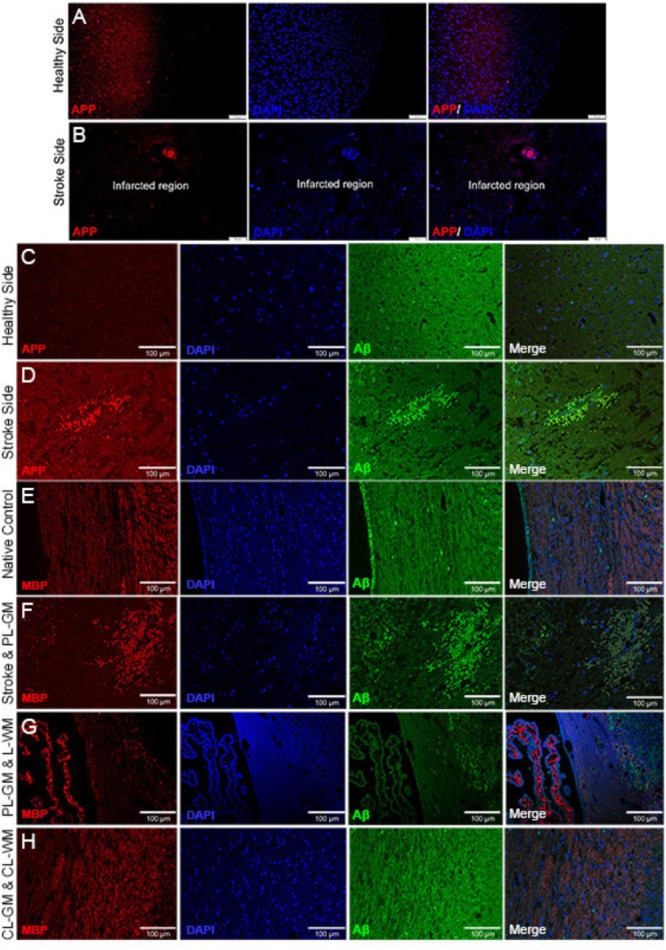
Immunohistochemistry staining identifying altered APP and Aβ1-42 in infarcted brain sections. (A,B) Contra-lesioned and lesioned hemispheres labeled with APP and DAPI: primary lesion gray matter (PS) shows amyloid precursor protein (APP) and contra-lesioned gray matter (CL-GM) with normal homogenous distribution of APP (red). (C,D) Contra-lesioned and affected stroke hemispheres were labeled with APP (red), DAPI (Blue) and Aβ1-42 (green). (E–H) Native control and 1-week affected stroke rat brains sections labeled with myelin basic protein (MBP, red), DAPI (blue), and Aβ1-42 (green). (F,G) Primary lesion gray matter (PS-GM) contains degenerated neurons (DAPI, blue) and disorganization of the myelin sheath (MBP, red) of the axonal neurons in the lesioned white matter (L-WM) scale bar = 100 μm for (A–H).